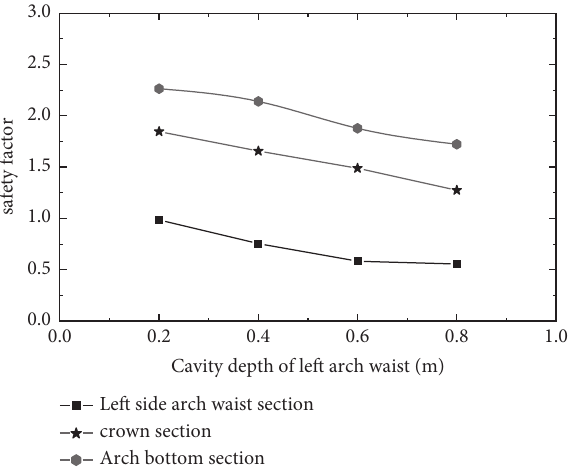
Figure 18: Variation law of safety coefficient of a typical section of the segment.